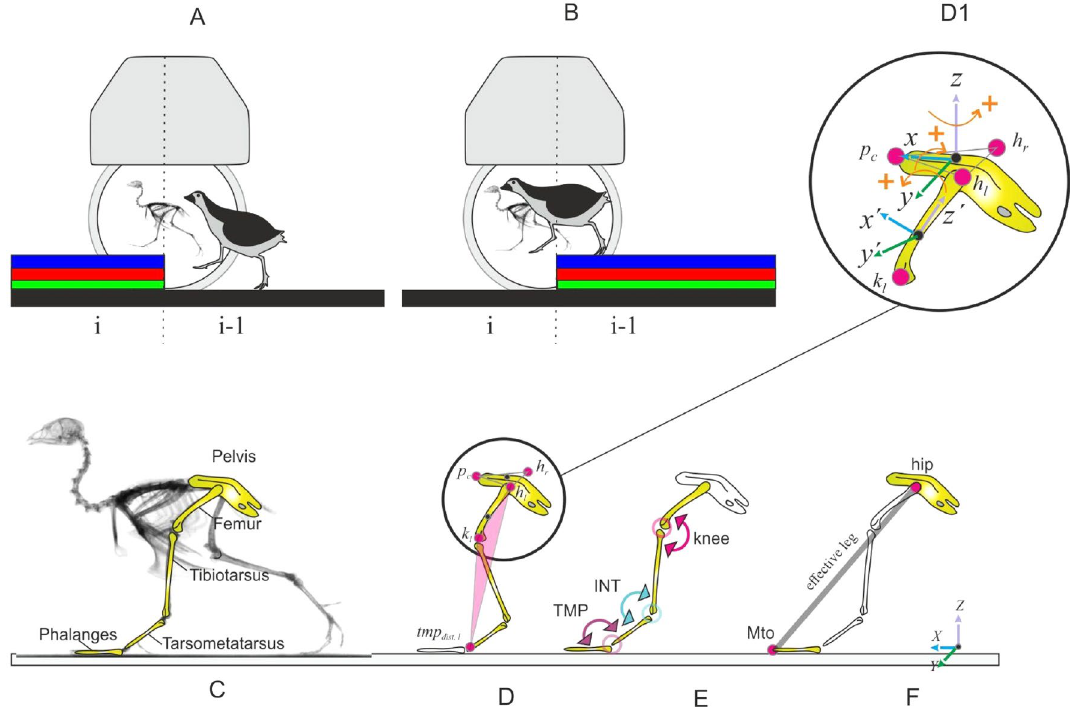
Figure 1. Experimental setup and 2D/3D global and joint limbs kinematics. The quail negotiated visible step-up ( A ) and step-down ( B ) steps of 1 cm (green), 2.5 cm (red), and 5 cm (blue) height. Body and hindlimb kinematics were captured using biplanar fluoroscopy. ( C ) Analyzed body segments. ( D ) 3D kinematics of the pelvis relative to the global coordinate system, and rotation of the whole leg related to the pelvis. The last estimates the three-dimensional rotations occurring at the hip joint. The whole leg is a plane formed by the hip (e.g., h l ), the knee (e.g., k l ) and the distal marker of the tarsometatarsus (tmt dist. l ). Coordinate systems for the pelvis and the leg can be seen in D1, see methods for further explanations, ( E ) joint kinematics ( INT intertarsal joint, TMP tarsometatarsal–phalangeal joint), ( F ) effective leg is the distance between tip of the middle toe (Mto) and the